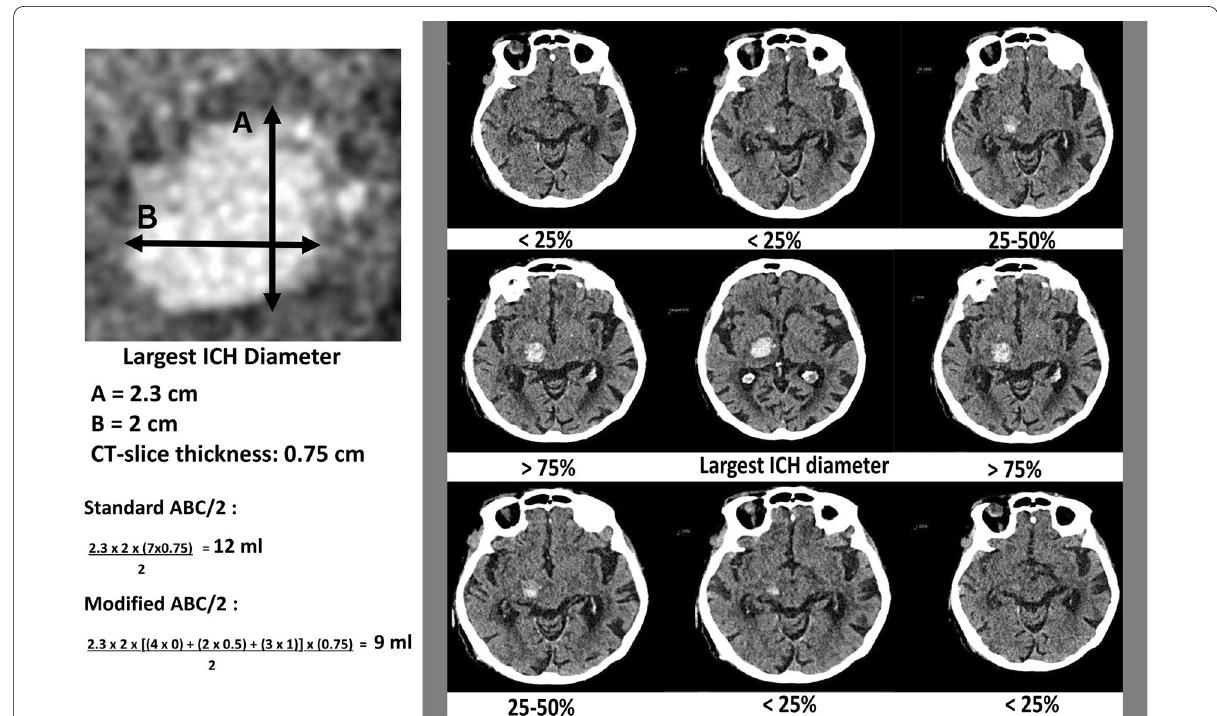
Fig. 7 ABC/2 method variants. Example of the standard ABC/2 and modified ABC/2 manual assessment of the hematoma